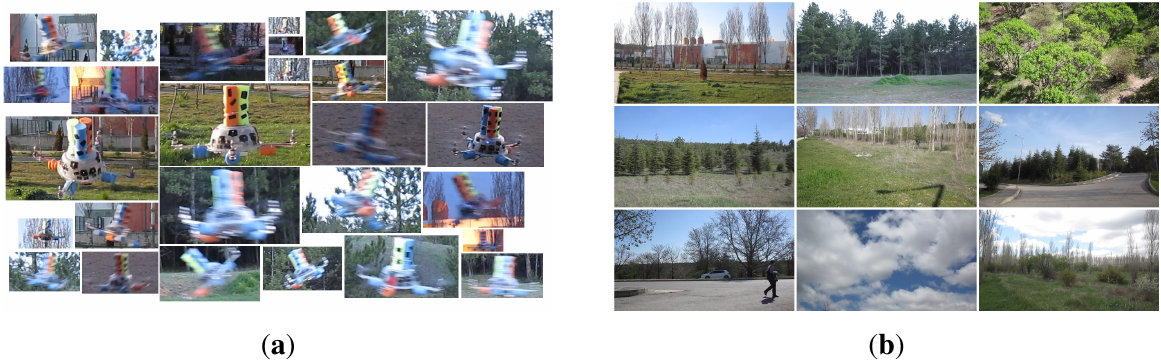
Figure 9. Example images from outdoor ( a ) quadrotor and ( b ) background training image sets. The images are colored; however, their grayscale versions are used in the